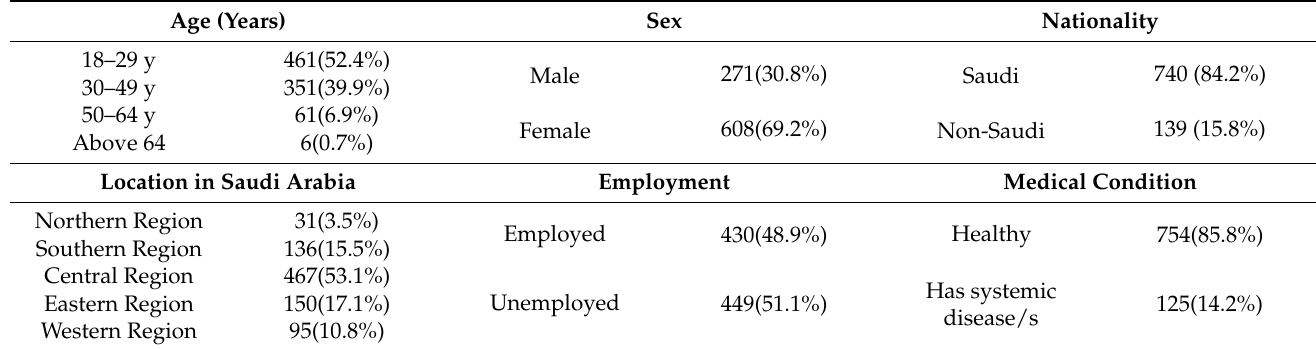
Table 1. Characteristics of participants (No = 879).